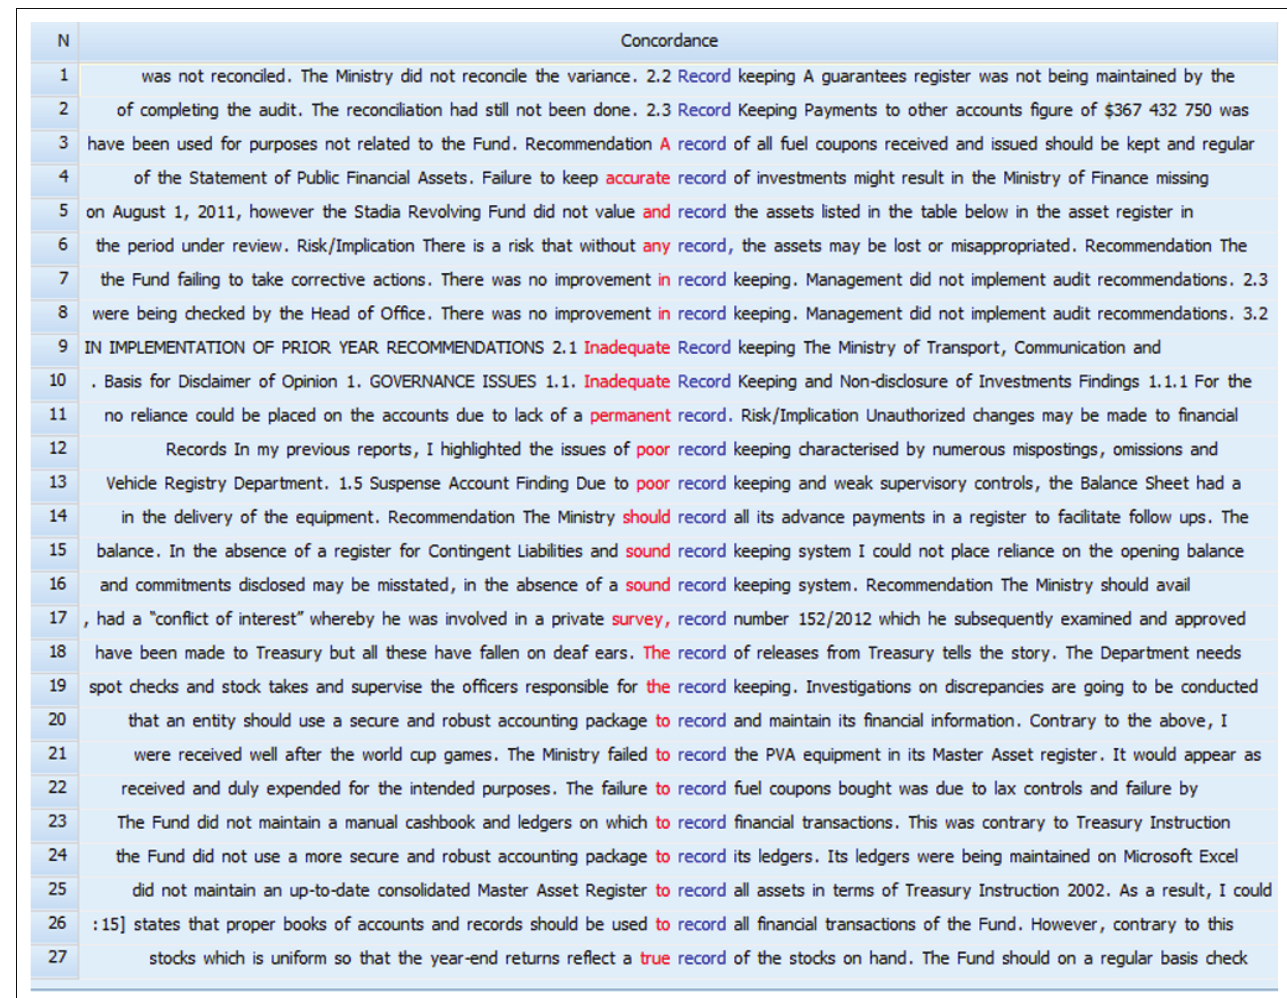
FIGURE 7: The Comptroller and Auditor General of Zimbabwe Summary and Statements of Audited Financial Accounts for the year ended 31 December 2012 for government